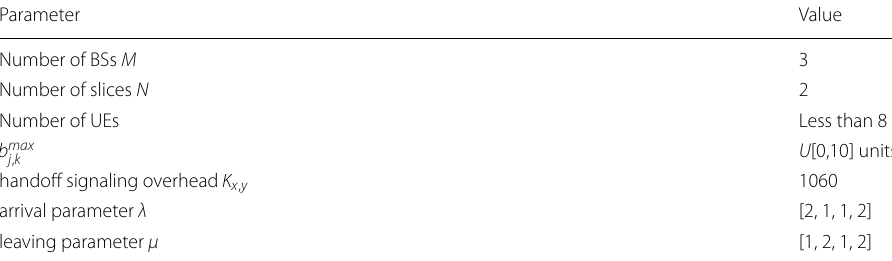
Table 1 Network parameters